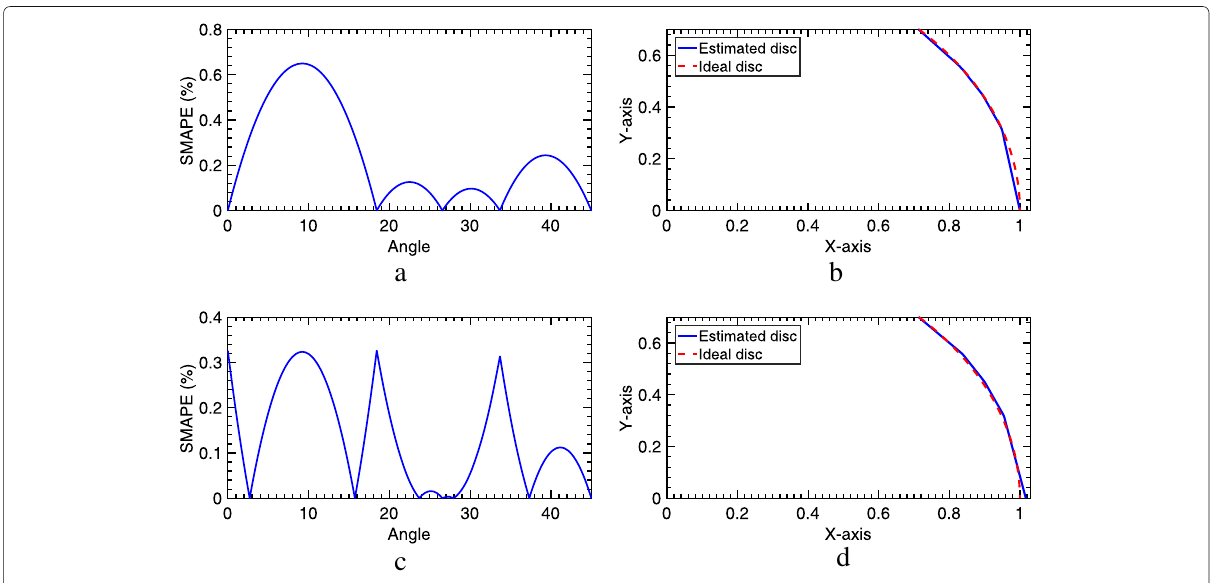
Fig. 8 Symmetric mean absolute percentage error and edge geometries generated by a 7 × 7 chamfer kernel. a Euclidean weights, a = 1, b = √ √ √ 5, d = 10, and e = 13. b Euclidean weights, a = 0.9935, b = c = √ √ ( 5 ) , d = 3.1417, and e = 3.5830. d Our weights, a = 0.9935, b = 2, c = b =